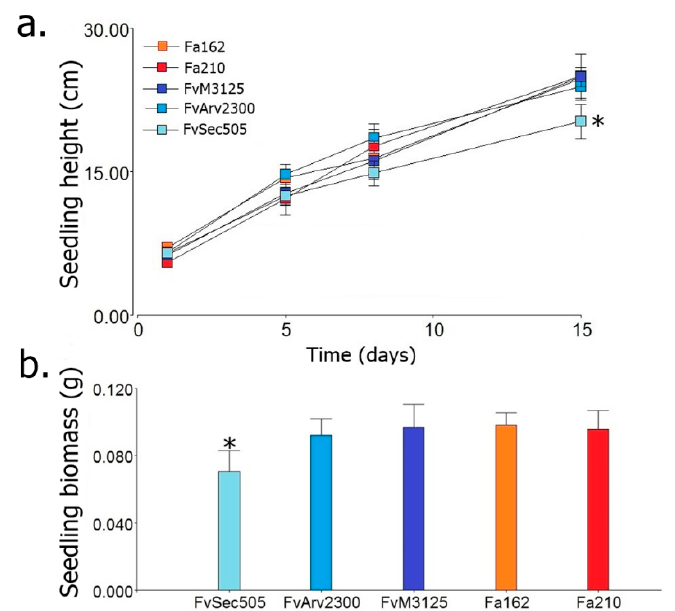
Figure 5. Phytopathogenicity of infected and mycovirus-free strains towards seedling of Zea mays L. ( a ) Growth of corn seedlings infected with the di ff erent fungal strains. The inoculation was carried out in the seeds, and the seedlings were cultivated in a hydroponic system with controlled photoperiod, temperature, and humidity. The height of the plant stem was measured after germination, when the coleoptile or the first leaf exceeded 5 cm in height. Measurements were taken on day one, four, eight, and fifteen post germination. The values are expressed as means of plant height, and the whiskers show standard error. The asterisk indicates a significant di ff erence with respect to the other measurements on the same day (multiple range DGC test, p < 0.05). ( b ) Plant biomass of infected seedlings. Values are expressed as biomass mean, and whiskers show standard error. The values containing an asterisk are statistically di ff erent from the others, according to the multiple range DGC test ( p < 0.05). In panels ( a , b ), Fusarium verticillioides and F. andiyazi strains were evaluated separately. The mycovirus-infected strains are Fusarium andiyazi 162 (Fa162 with FaMV1-162) and F. verticillioides Sec505 (FvSec505 with FvMV1), and the virus-free strains are F. andiyazi 210 (Fa210), F. verticillioides M3125 (FvM3125) and F. verticillioides Arv2300 (FvArv2300).